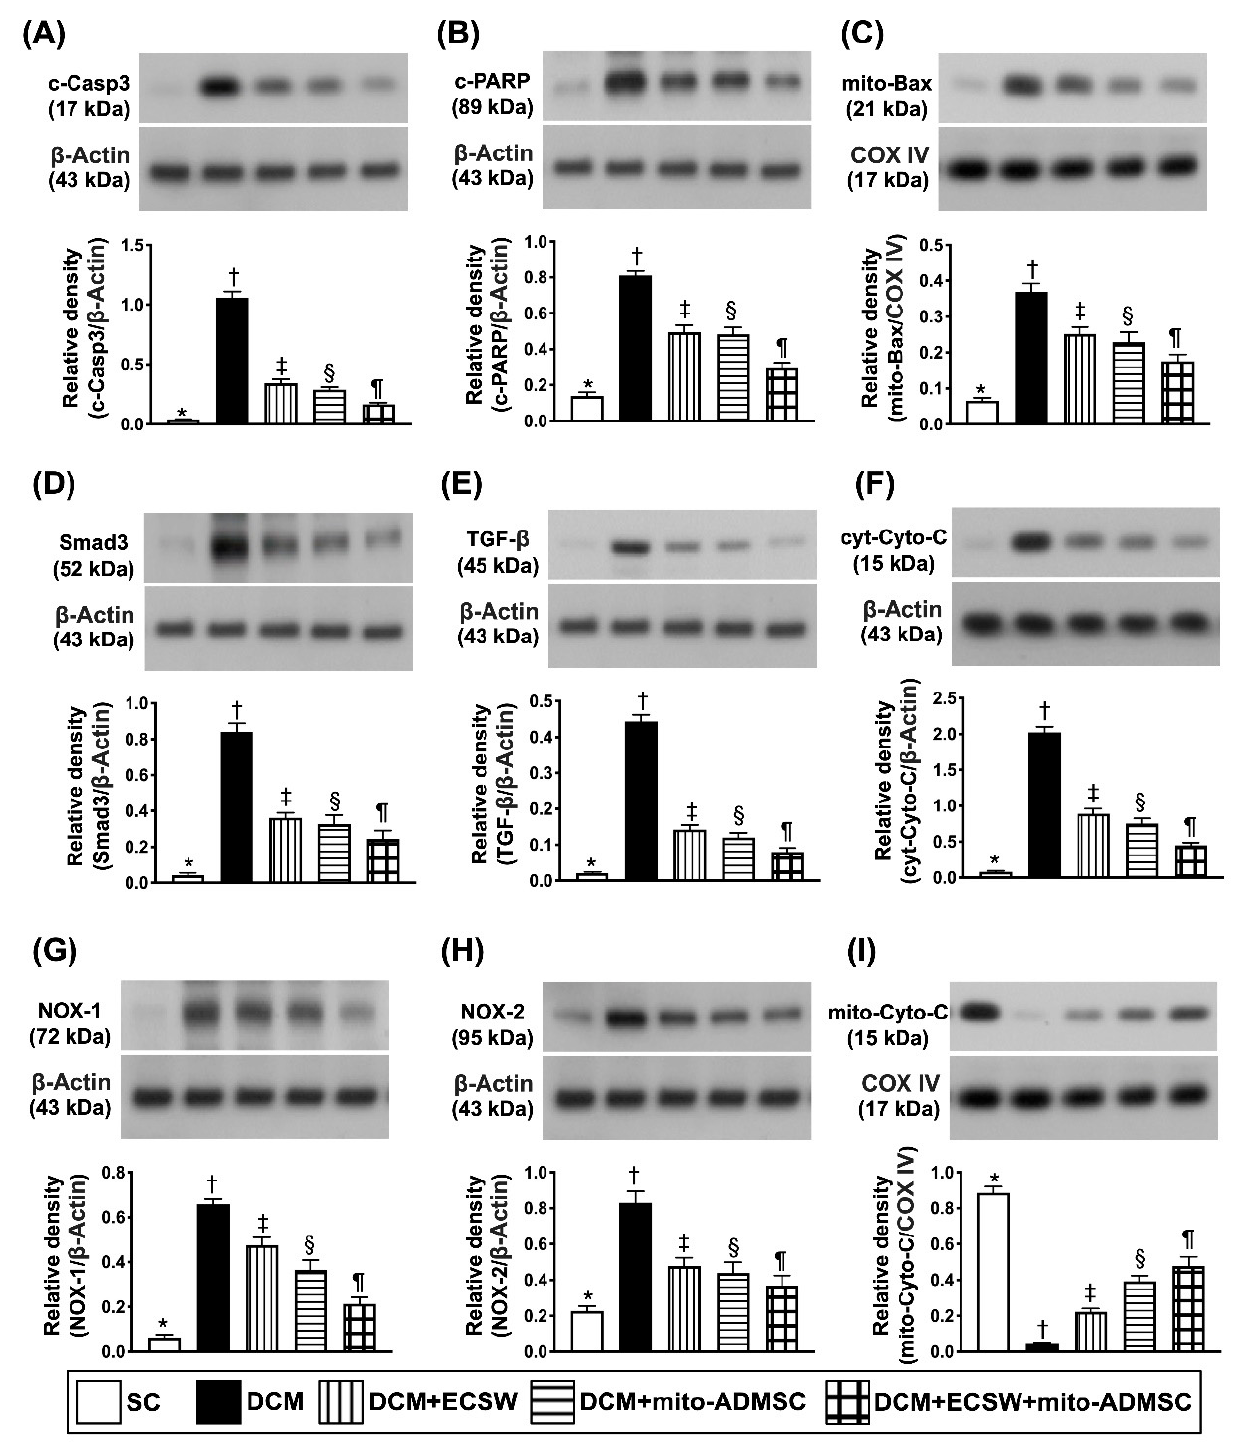
Figure 9. Apoptosis, fibrosis, oxidative stress and mitochondrial damage marker in LV myocardium 7 weeks after DCM induction. ( A ) Protein expression of cleaved caspase 3 (c-Casp3), * vs. other groups with different symbols (†, ‡, §, ¶), p < 0.0001. ( B ) Protein expression of c-PARP, * vs. other groups with different symbols (†, ‡, §, ¶), p < 0.0001. ( C ) Protein expression of mitochondrial (mito)-Bax, * vs. other groups with different symbols (†, ‡, §, ¶), p < 0.0001. ( D ) Protein expression of Smad3, * vs. other groups with different symbols (†, ‡, §, ¶), p < 0.0001. ( E ) Protein expression of transforming growth factor (TGF)-ß, * vs. other groups with different symbols (†, ‡, §, ¶), p < 0.0001. ( F ) Protein expression of cytosolic cytochrome C (cyt-Cyto-C), * vs. other groups with different symbols (†, ‡, §, ¶), p < 0.0001. ( G ) Protein expression of NOX-1, * vs. other groups with different symbols (†, ‡, §, ¶), p < 0.0001. ( H ) Protein expression of NOX-2, * vs. other